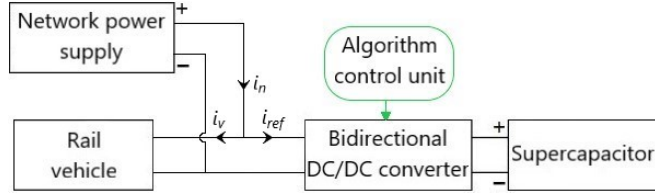
Figure 1. Simplified model of the regenerative braking system.